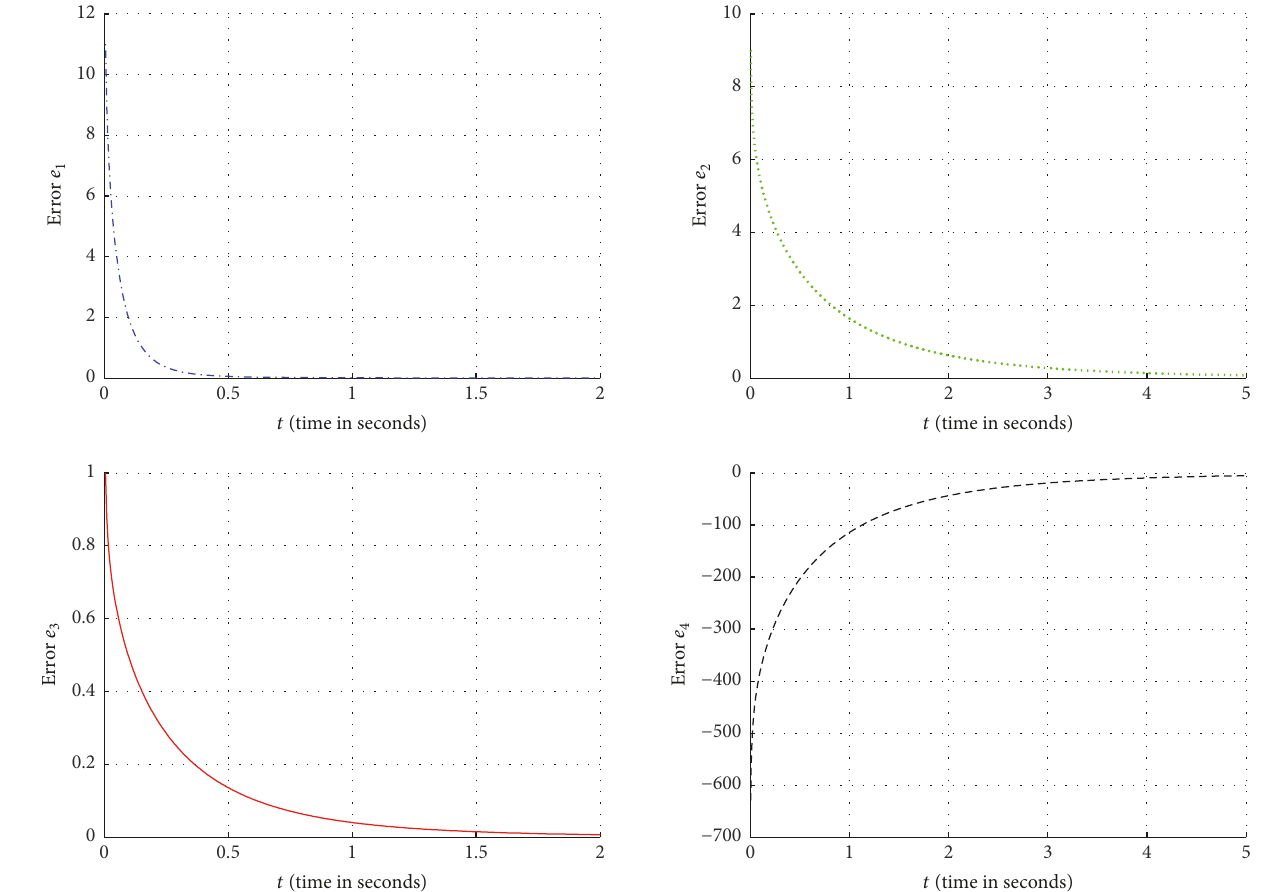
Figure 3: Time evolution of the synchronization errors 𝑒 1 , 𝑒 2 , 𝑒 3 , and 𝑒 4 between master system (26) and slave system (27).